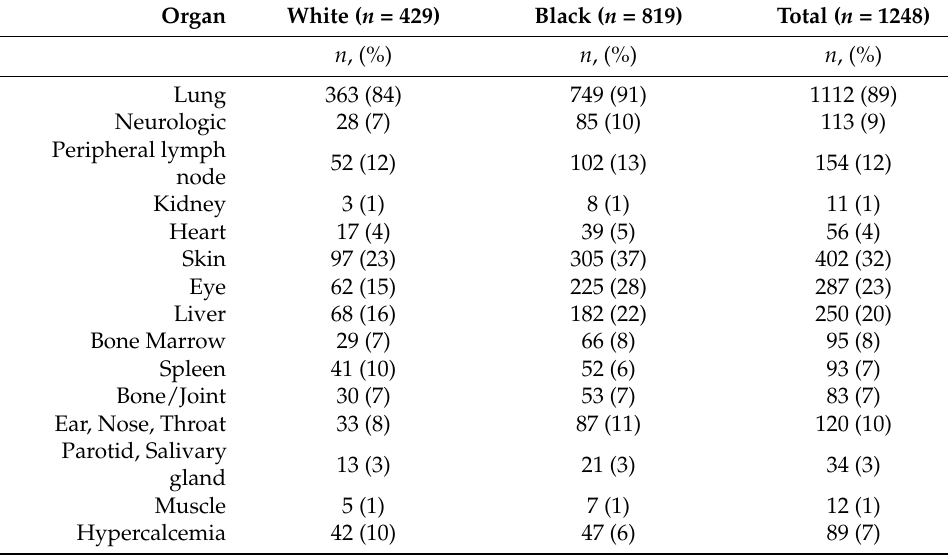
Table 1. Frequency of sarcoidosis organ involvement in a large cohort *. Organ White ( n = 429) Black ( n = 819) Total ( n = 1248) n , (%) n , (%) n ,